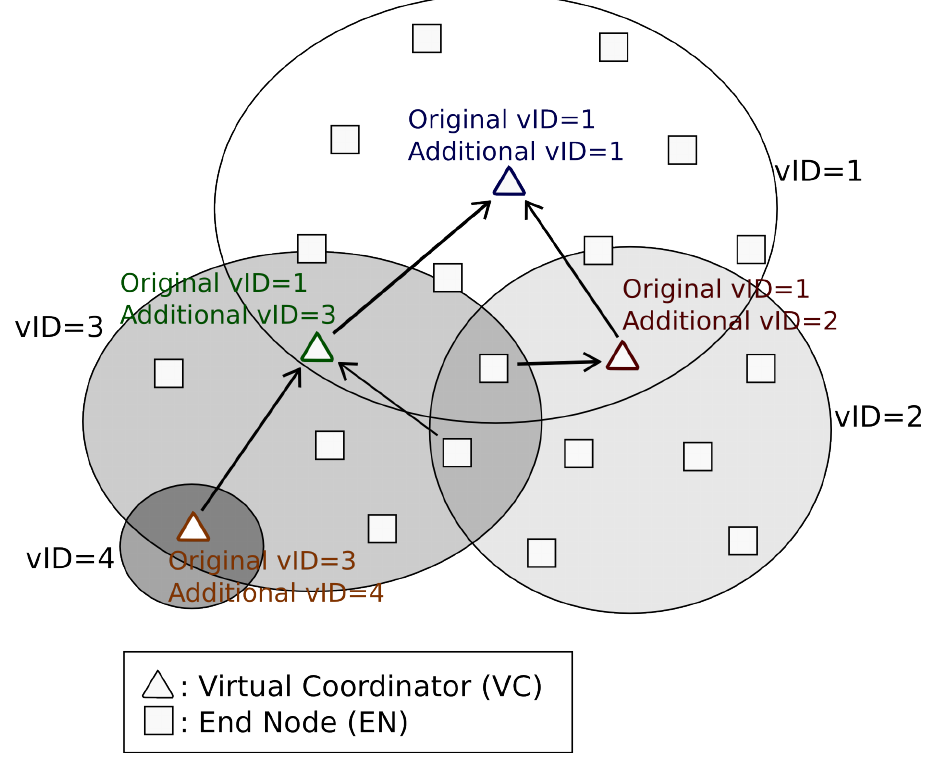
Figure 6. Example of virtual sub-networks’